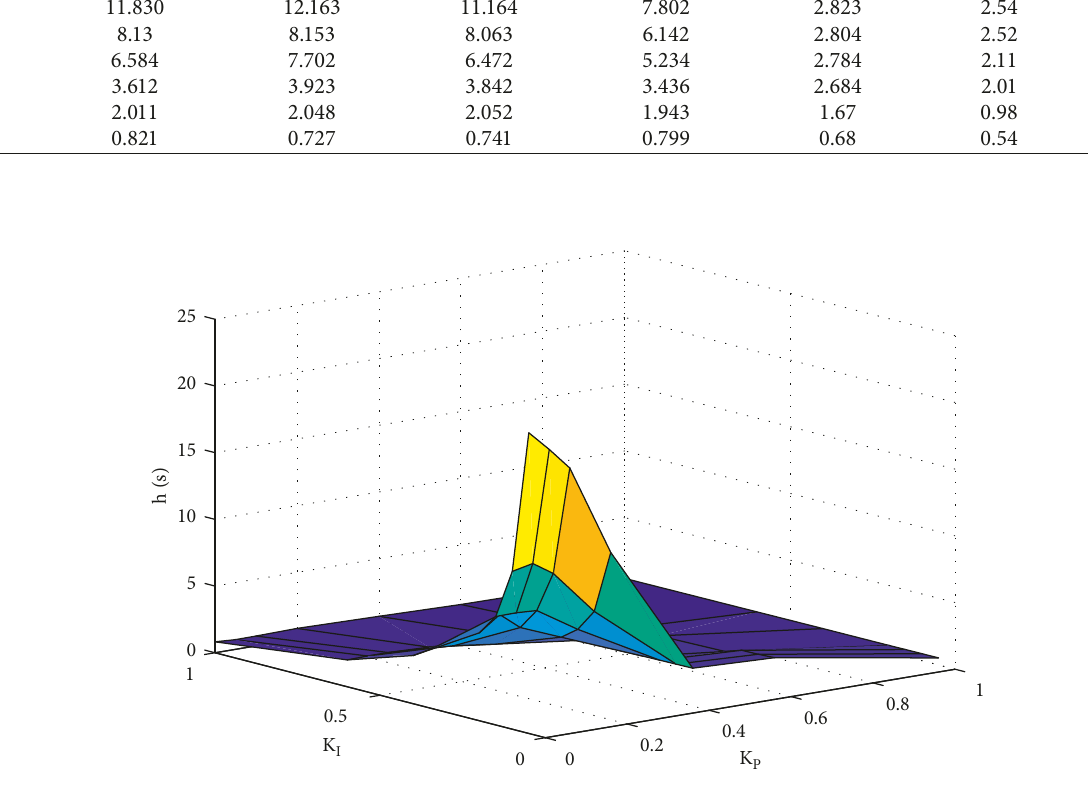
Figure 6: h ∝ ( K , K ) (single-area with μ � 0 . 9 , ρ � 0 . 025 , τ � 0 . 025). P I Table 7: Delay margin h by Theorem 1 for two-area LFC with ϱ � 0 , τ � 0.